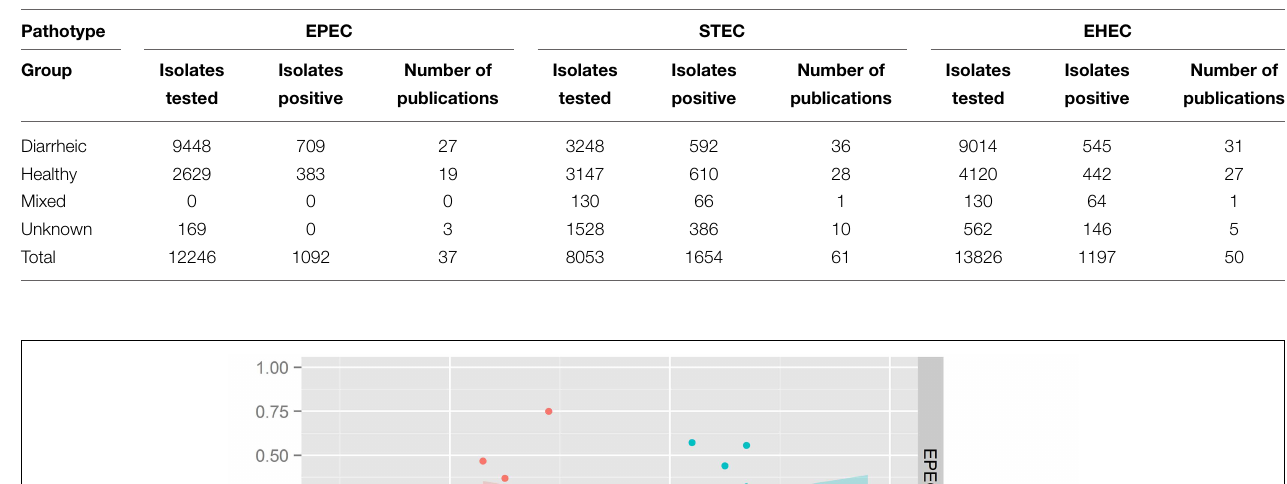
FIGURE 3 | STEC, EPEC, EHEC prevalence in between 1986 and 2010. Each subpanel corresponds to one pathotype. The color of dots describes health status of animals: red, diarrheic animals; blue, healthy animals. The